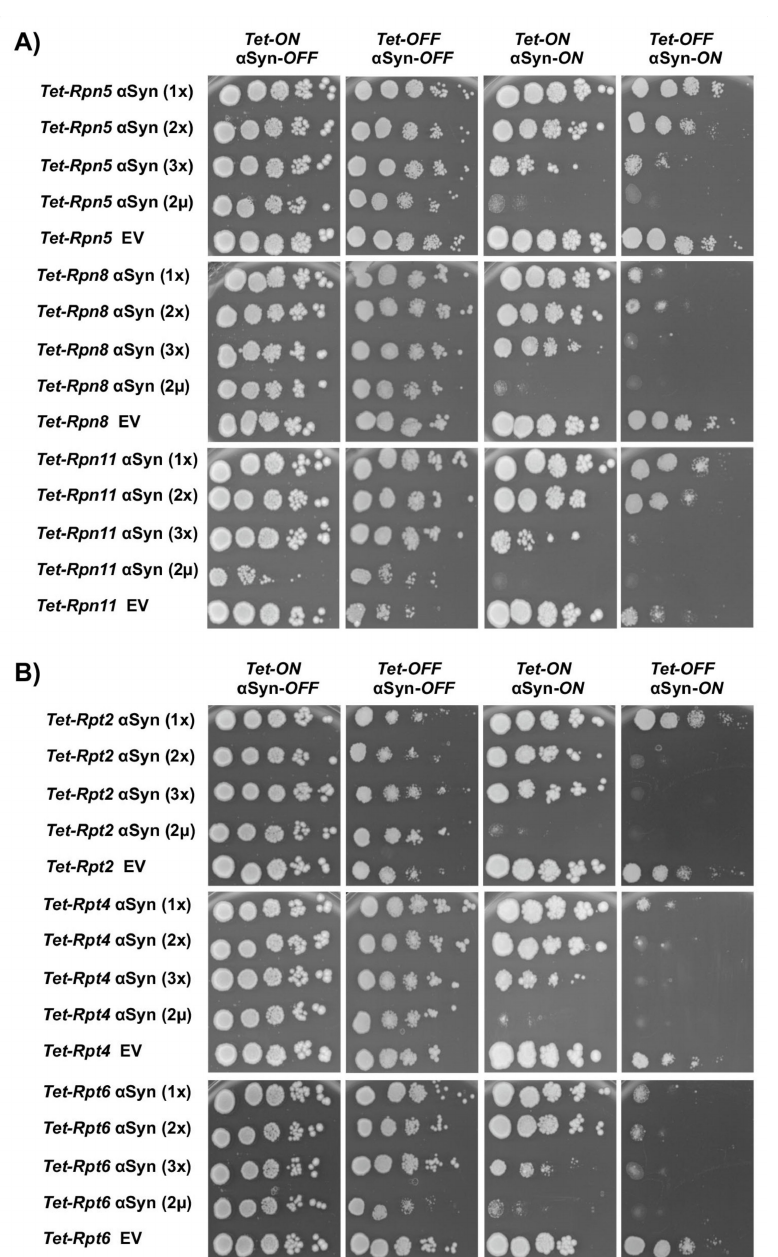
Figure 3. Growth effect on yeast cells upon interaction between α Syn and the Tet alleles of the essential genes encoding the lid ( A ) or base ( B ) subunits. Growth assays of yeast cells expressing GAL1 -driven α Syn-GFP from one (1 × , two (2 × ) or three (3 × ) gene copies or overexpressed from a 2 µ plasmid with an empty vector (EV) as a control. Cells were spotted in 10-fold dilutions on selective plates containing glucose ( α Syn- OFF ) or galactose ( α Syn- ON ), in the presence ( Tet-OFF ) or absence ( Tet-ON ) of 10 µ g/mL doxycycline that represses the Tet promoter. The plates were incubated at 30 ◦ C for 5